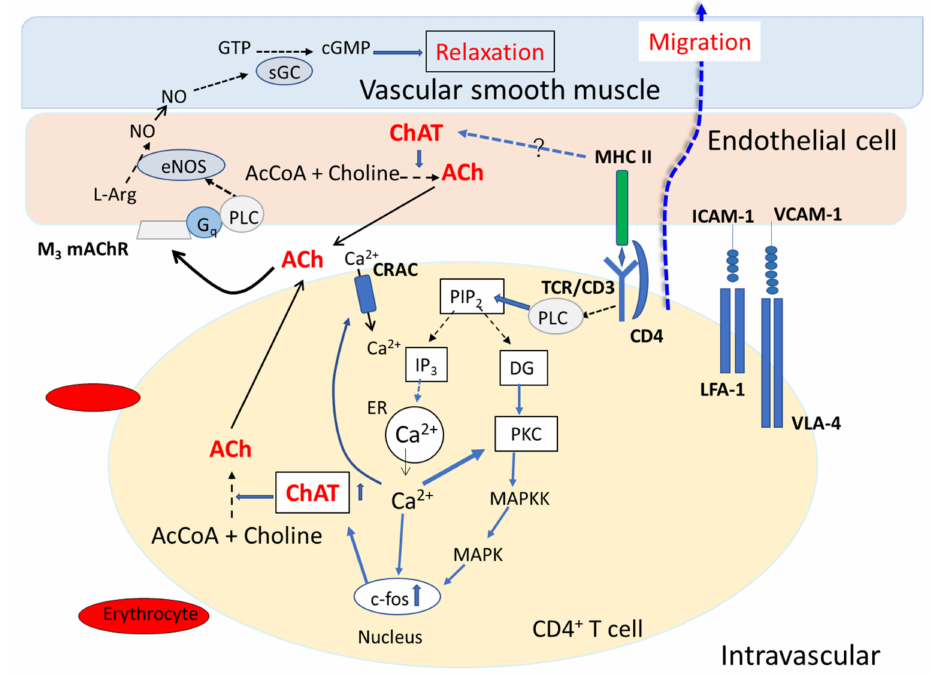
Figure 2. Schematic drawing illustrating the interaction between a vascular endothelial cell (VEC) and a CD4 + T cell, leading to cholinergic activation and transendothelial migration of the T cell. Interaction between vascular endothelial cells (VECs) and CD4 + T cells is mediated by specific interactions between major histocompatibility complex II (MHC II) and the T cell receptor/CD3 complex (TCR/CD3), between intercellular cell adhesion molecule-1 (ICAM-1) and lymphocyte function-associated antigen-1 (LFA-1), and between vascular cell adhesion molecule-1 (VCAM-1) and very late antigen-4 (VLA-4). Stimulation of TCR/CD3 signaling pathways in CD4 + T cells activates phospholipase C (PLC), leading to conversion of phosphatidyl 4,5-bisphospahe to inositol 1,4,5- trisphosphate (IP 3 ) and diacylglycerol (DG). IP 3 induces Ca 2+ release from the endoplasmic reticulum (ER). The released Ca 2+ induces influx of extracellular Ca 2+ through the calcium release-activated channel (CRAC). DG with Ca 2+ activates protein kinase C (PKC). PKC activates mitogen-activated protein kinase (MAPK) kinase (MAPKK), which in turn activates MAPK. MAPK promotes c-fos mRNA expression in the nucleus, leading to up-regulation of choline acetyltransferase (ChAT)